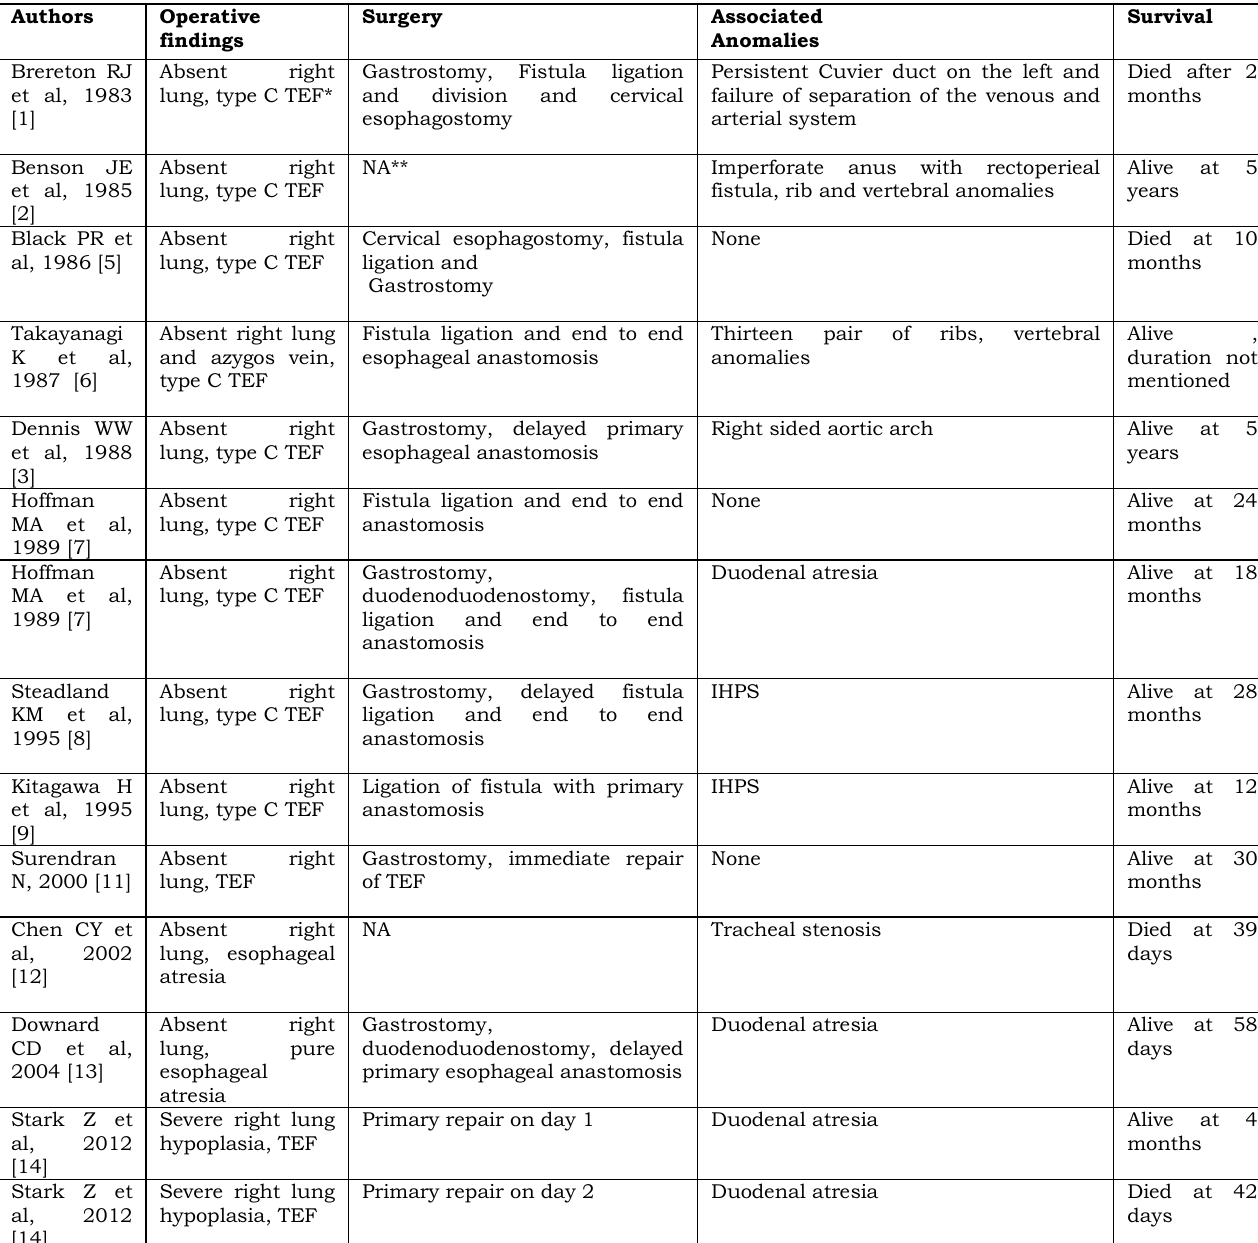
Table 1: Showing patient details who survived beyond newborn